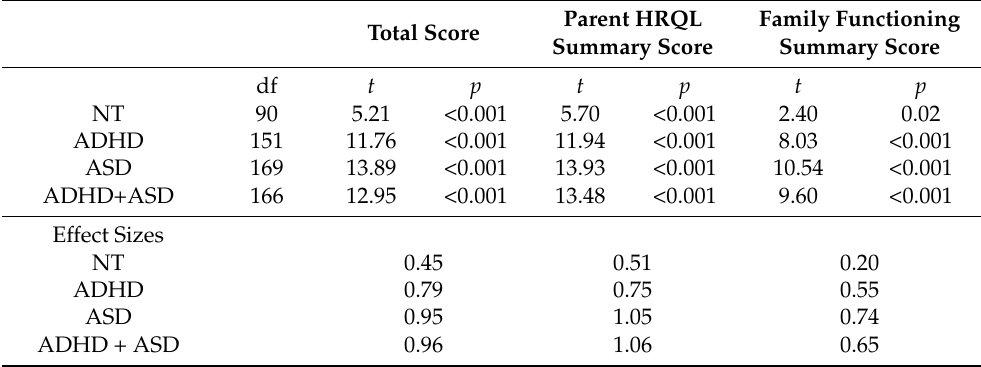
Table 4. Results from the paired t -tests and effect size (Cohen’s d ) calculations before and during COVID-19 for each diagnosis.